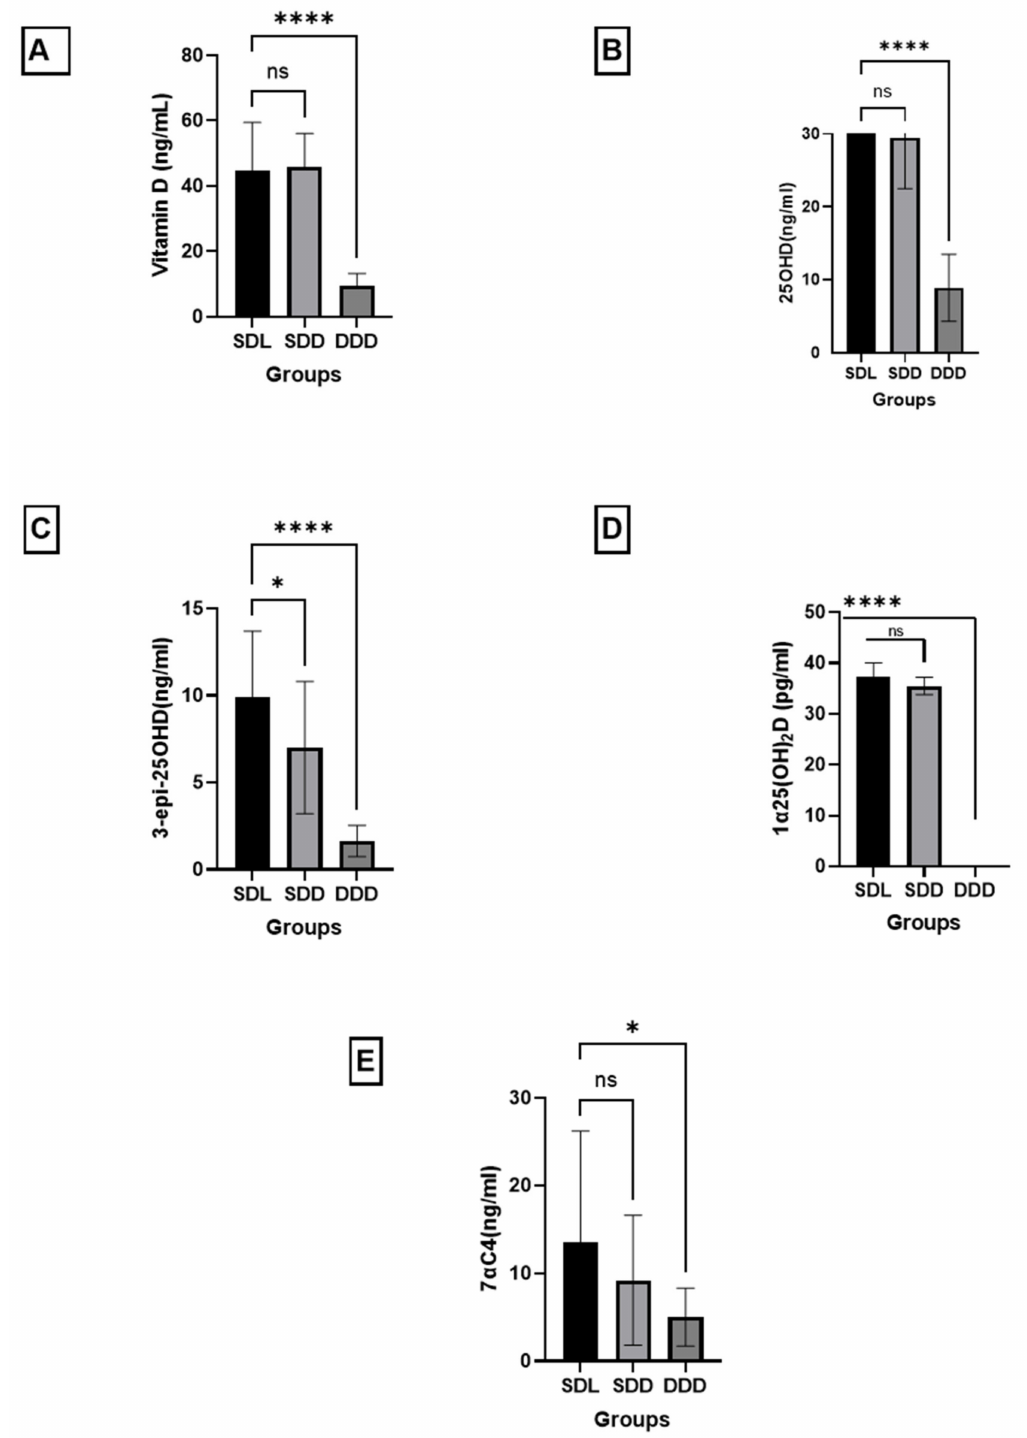
Figure 3. The levels of vitamin D metabolites and epimers in mouse serum, namely, ( A ) vitamin D, ( B ) 25OHD, significant differences between group SDL, SDD and DDD. The error bars represent standard deviations. A one-way analy- sis of variance (ANOVA) (Bartlett’s test) or Student’s t -test (two-tailed) was used when required. The differences between the results were considered significant if p < 0.05, refuting the null hypothesis ( p < 0.05). “ns” means no significant